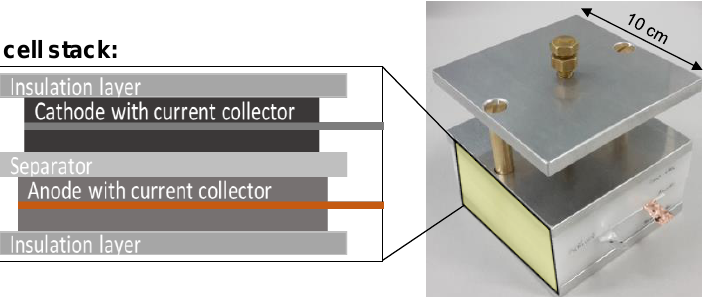
Figure 2. Pressure device ( right ) for the cell stack ( left ) consisting of a separator sandwiched with the cathode and the anode, as well as insulation layers on both sides.